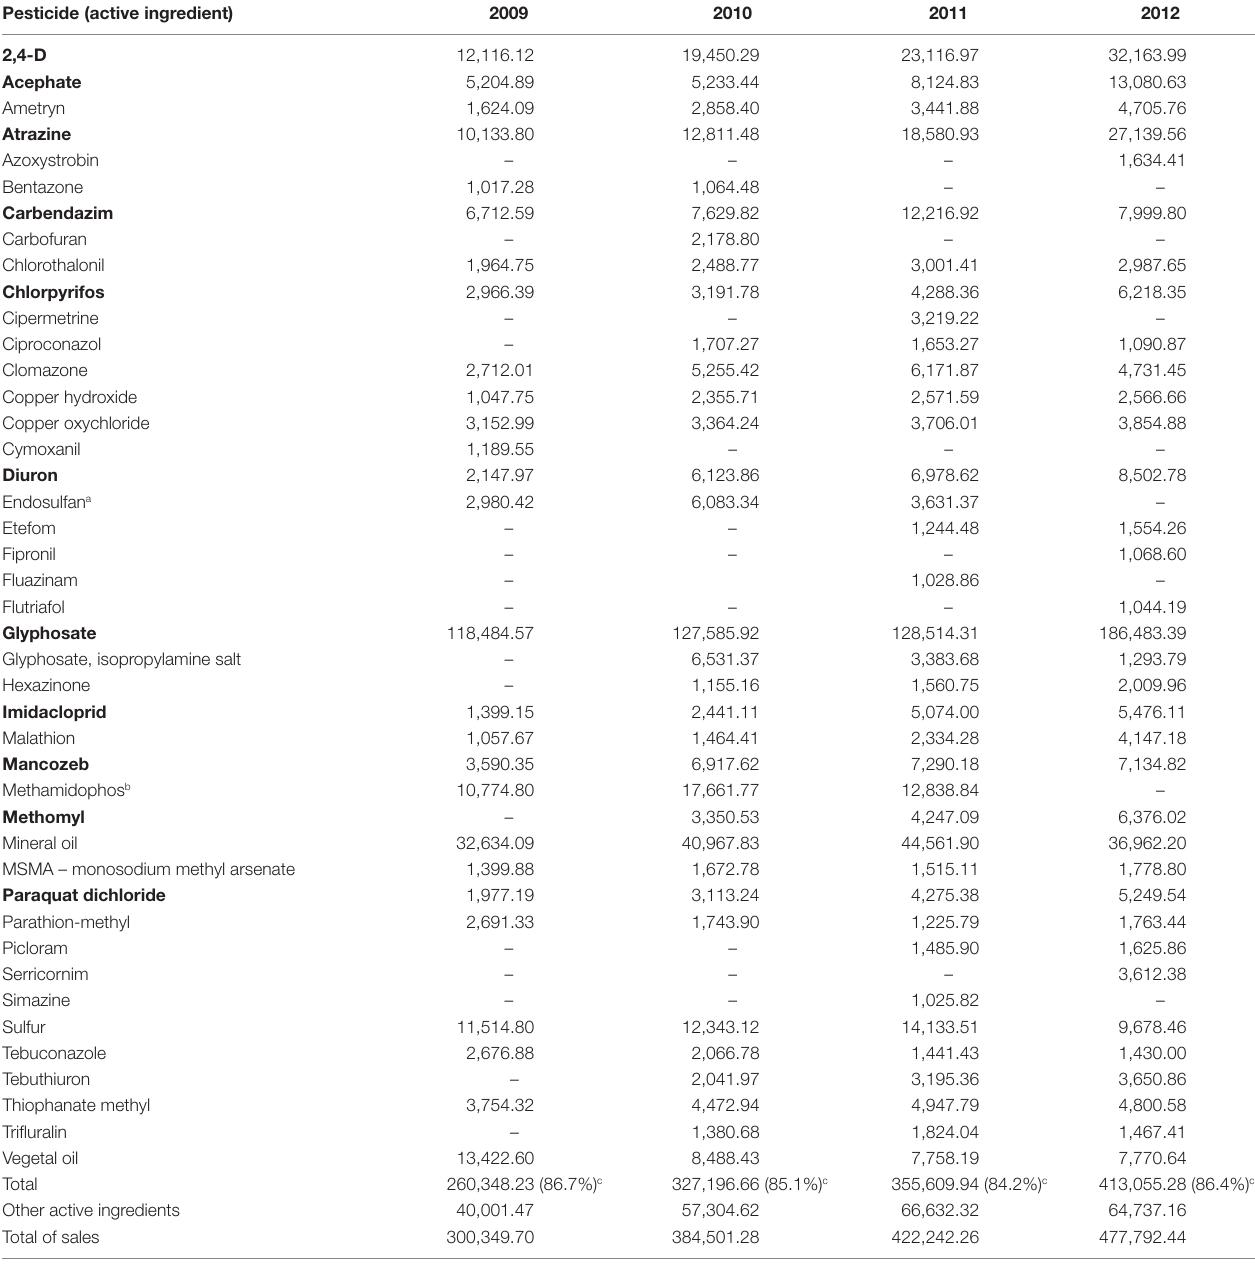
TaBle 2 | The highest volume pesticide active ingredients in Brazil from 2009 to 2012 (above 1,000 tons/year). Pesticide (active